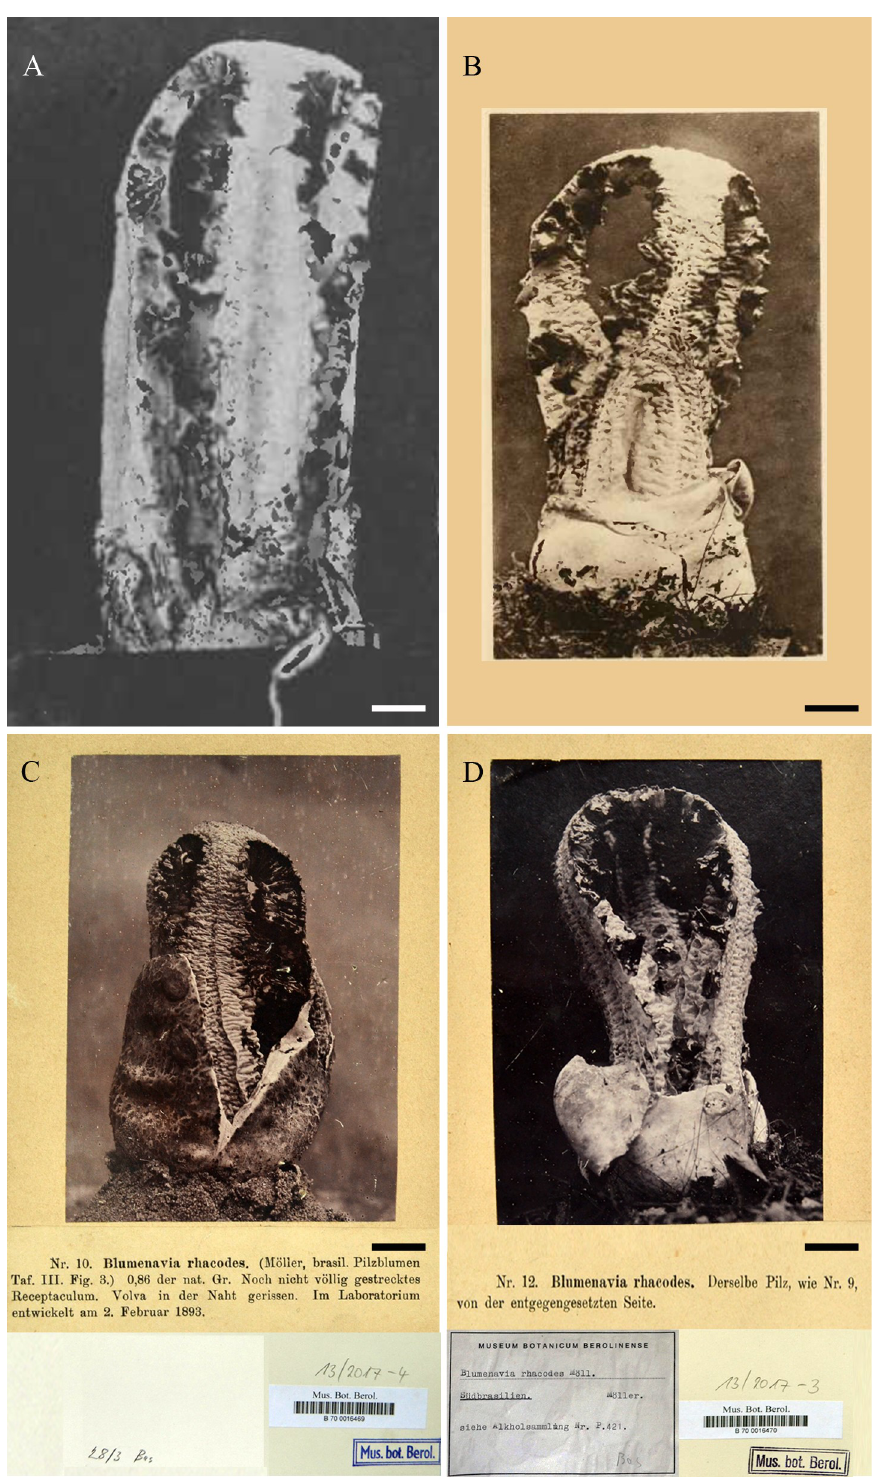
Fig 8. Blumenavia rhacodes photographs. (A–C) Reproduced from Mo¨ller [3], Tab. III: (A) Fig 1A sintype; (B) Fig 2 sintype; (C) Fig 3, lent from B Herbarium B700016469, sintype. (D) Lent from B Herbarium, B700016470. (A–D) bar = 10